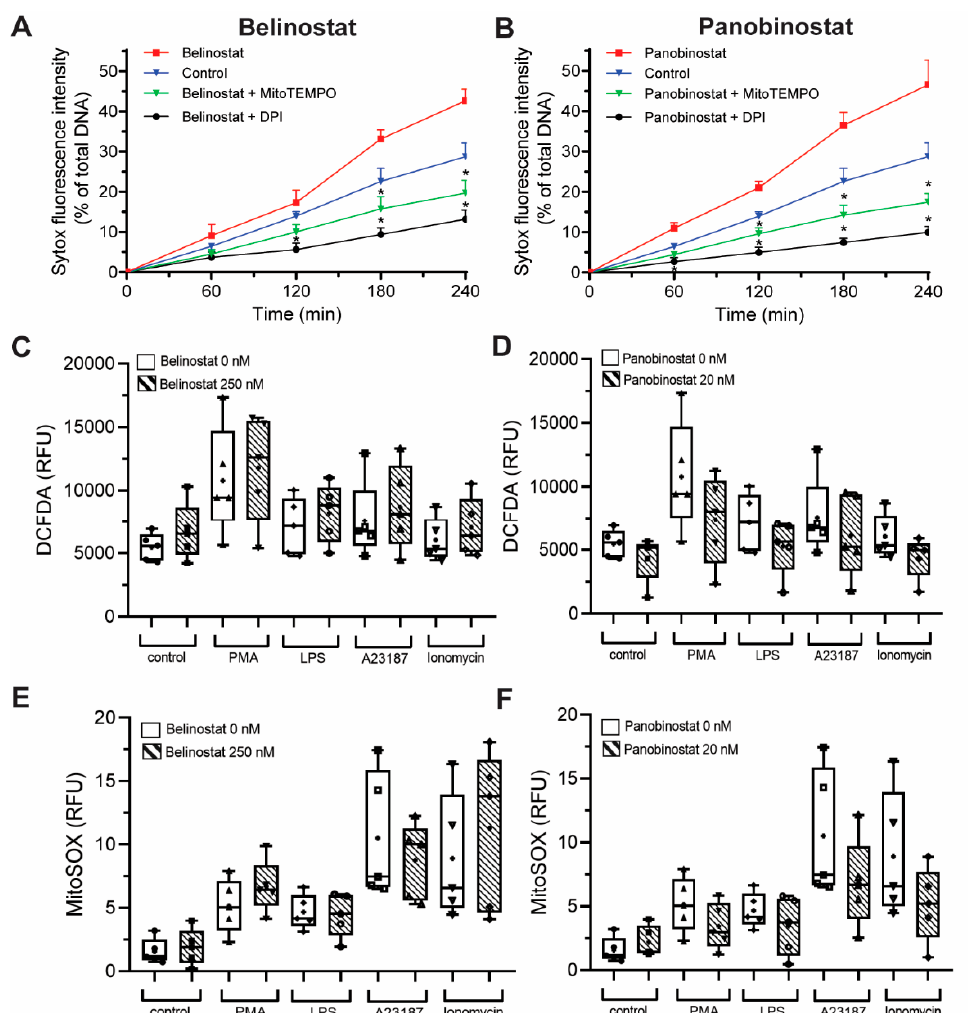
Figure 5. HDACis-mediated NETosis requires ROS production, but these inhibitors do not alter ROS production. Neutrophils were treated with 250 nM belinostat or 20 nM panobinostat in the presence or absence of NOX inhibitor and a mROS scavenger, 1 µ M DPI and 200 µ M MitoTEMPO, respectively. After 4 h treatment, Sytox Green fluorescence intensities were then measured every 60 min for up to 4 h by using a fluorescence plate reader. ( A , B ) Neutrophils cotreated with DPI or MitoTEMPO had significantly lower NETosis than belinostat ( A ) or panobinostat ( B ) treated cells. ( C – F ) DHR123 and MitoSOX assays measuring NOX- and mitochondrial-derived ROS production of neutrophils at 30 min, respectively. Neutrophils treated with belinostat ( C , E ) or panobinostat ( D , E ) do not promote intracellular ROS or mROS levels. Kinetics data are presented as mean ± SEM. In box graphs, full data spread is indicated with lines and boxes are marked with the mean (+), median and upper and lower interquartile ranges. ROS generation data assessed by using DCFDA ( C , D ), while by MitoSOX ( E , F ). *, p < 0.05 (One-Way ANOVA with Tukey post-test conducted at each time points; n = 4). See Supplementary Figures S7 and S8 for additional information.